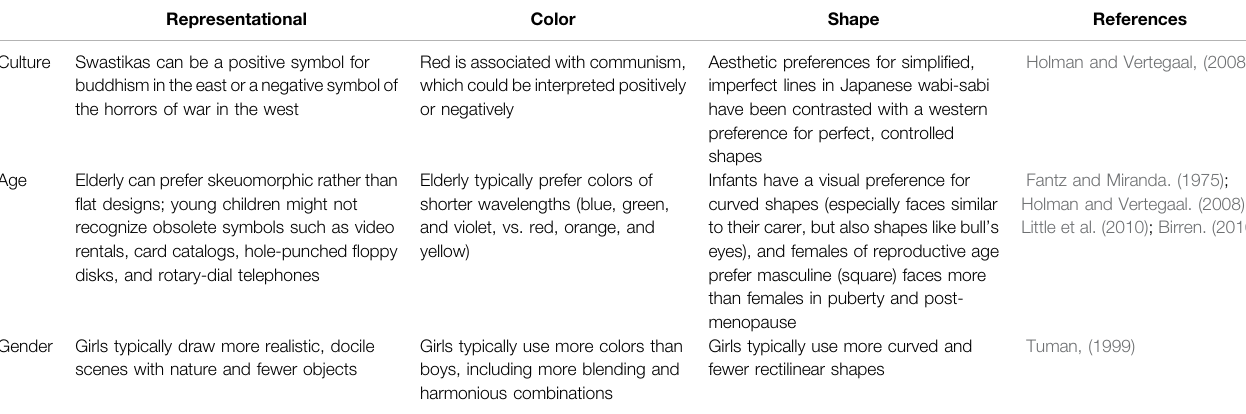
TABLE 4 | Examples of effects of culture, age, gender on visual